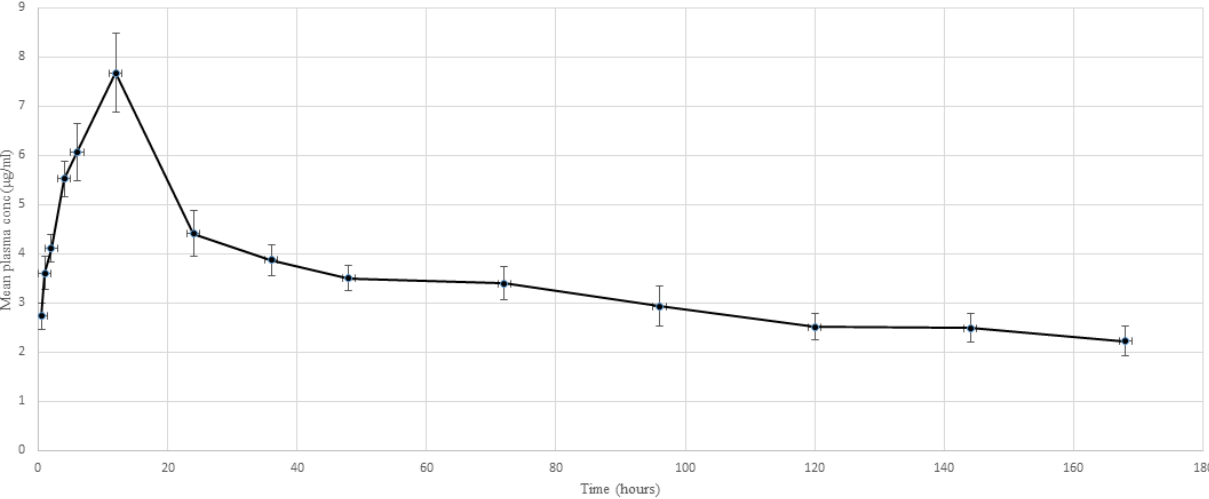
Figure 3. Semi logarithmic plot of the mean blood concentration ( µ g mL − 1 ) of amitraz against time following a single dermal application at 0.25 percent in lactating does. ( n = 6).